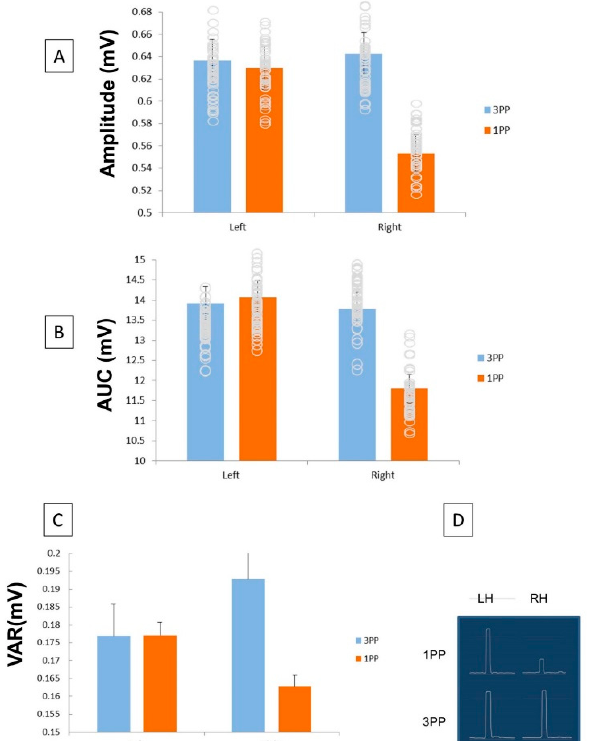
Figure 2. The peak ( A ), AUC (area under the curve) ( B ) and SD (standard deviation) ( C ) across Hemisphere for 1PP and 3PP. In all 3 measures, the 1PP Right Hemisphere condition differed significantly from all other conditions (all p < 0.05). All other comparisons were non-significant. A representative rectified, smoothed MEP is given for the 1PP ( D ) for RH and LH. A second repeated-measures ANOVA was calculated to examine AUC